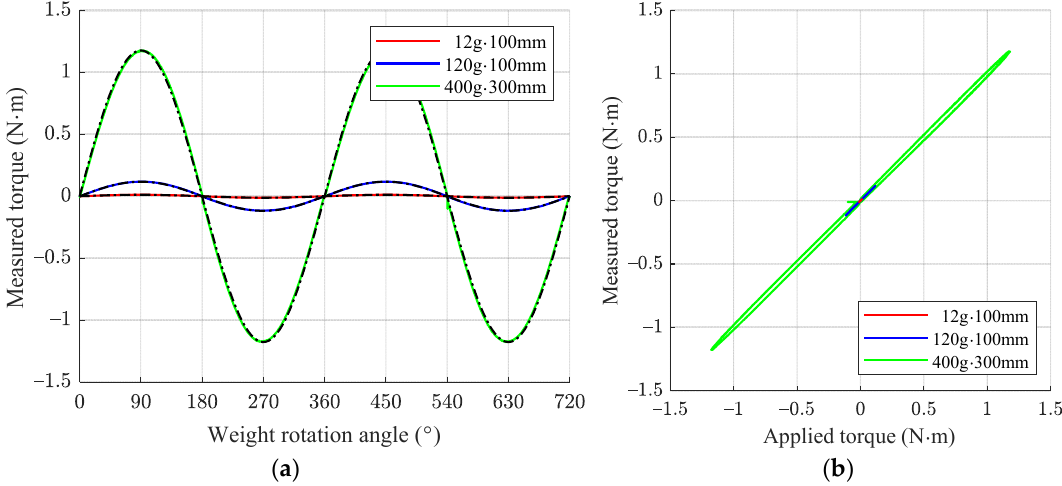
Figure 9. The torque measured by three different applied sinusoidal torque input: 12 g weight 100 mm apart, 120 g weight 100 mm apart, and 400 g weight 300 mm apart. Dash-dotted lines represent fitted sine curves. The x -axis is ( a ) the input rotation angle and ( b ) the converted torque.